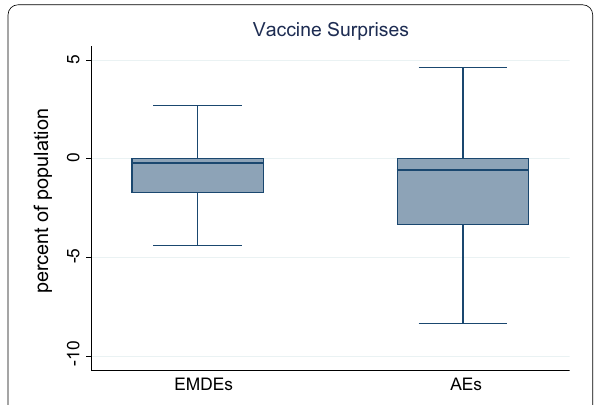
Fig. 1 Vaccine surprises, people fully vaccinated (percent of